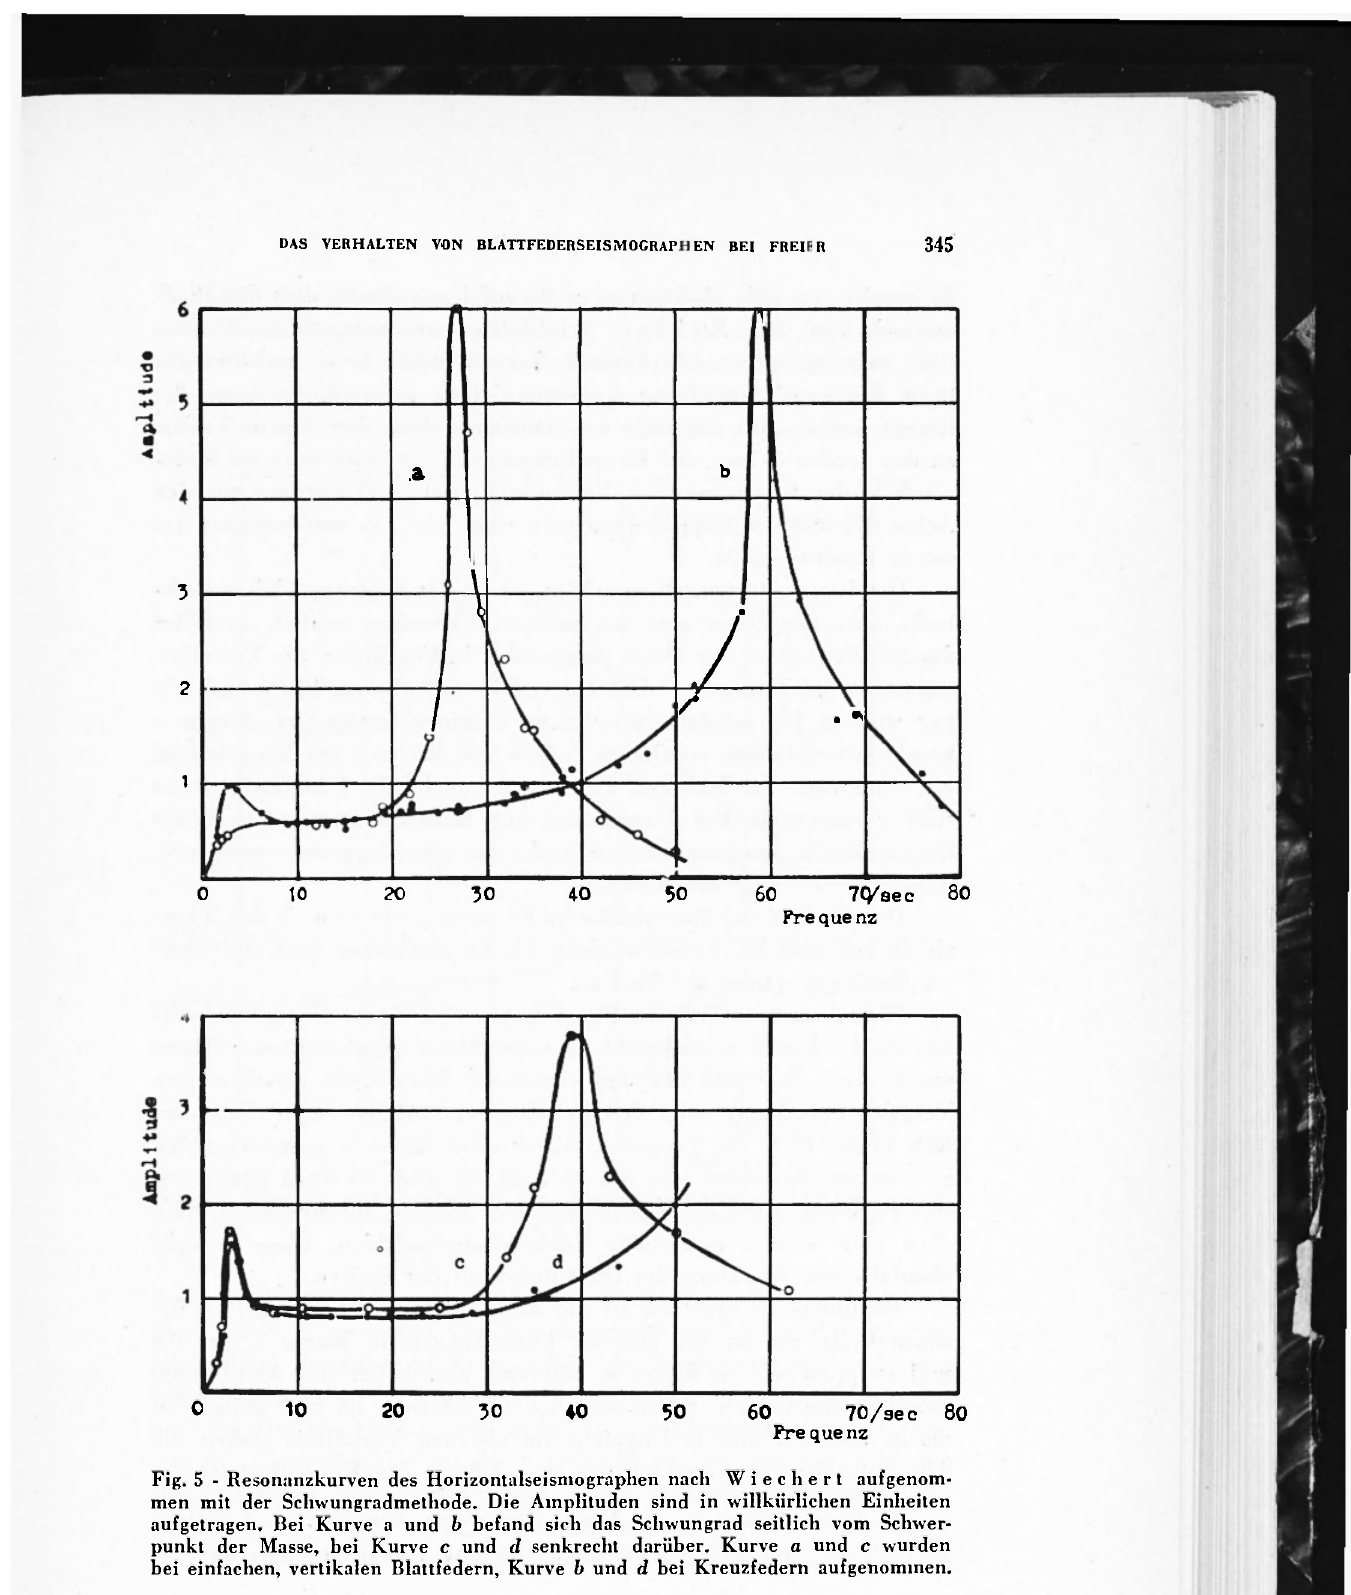
Fig. 5 - Resonanzkurven des Horizontalseismographen nach W i e c h e r t aufgenom- men mit der Scliwungradmethode. Die Ainplituden sind in willkiirlichen